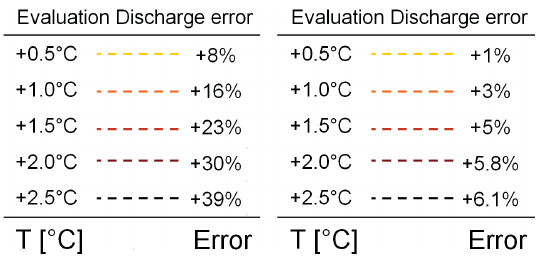
Fig. 11. Evaluation discharge errors based on a rise in temperature over the Toce (left) and Sesia (right) basins. The percentage of er- rors refers to the main peak discharge which occurred on 5 Novem- ber 2008. The legend of coloured dashed lines of the snow line rise is the same shown in Fig.